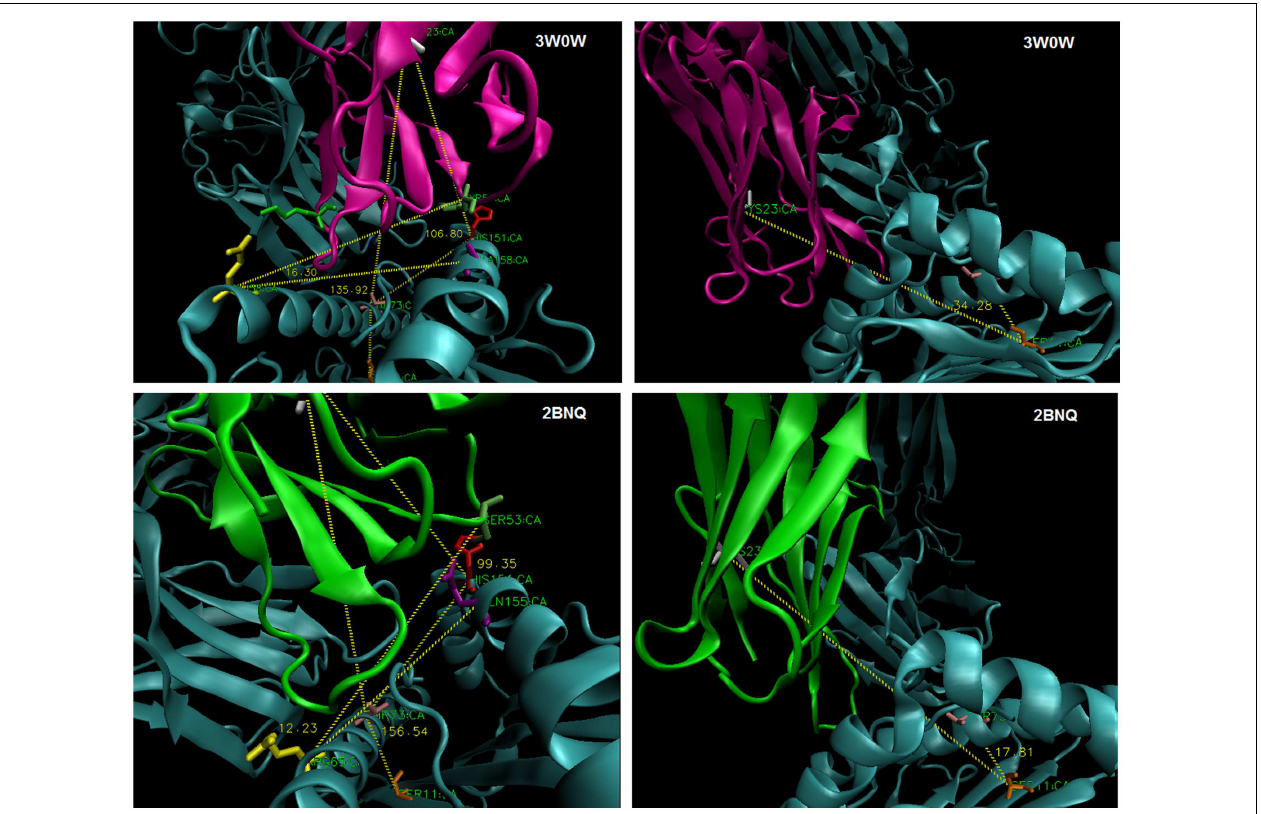
FIGURE 6 | Estimating TCR twist/tilt/sway: (left) measuring an angle across the groove to C22/3/4 of TCR-V α (“twist”) and perpendicular to the groove to C22/3/4 (“tilt”); (right) measuring an angle parallel to the groove (“sway”) .